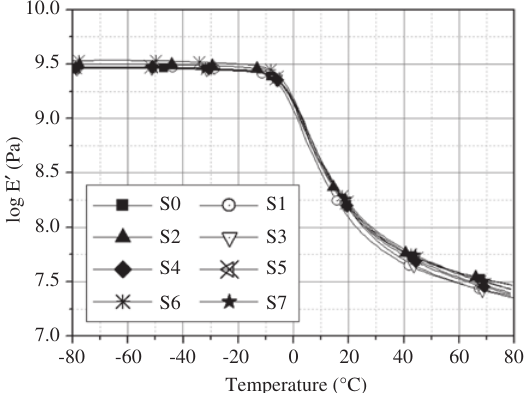
Figure 3 Dynamic mechanical properties: heat build-up of the studied composites as a function of dynamic deformation.